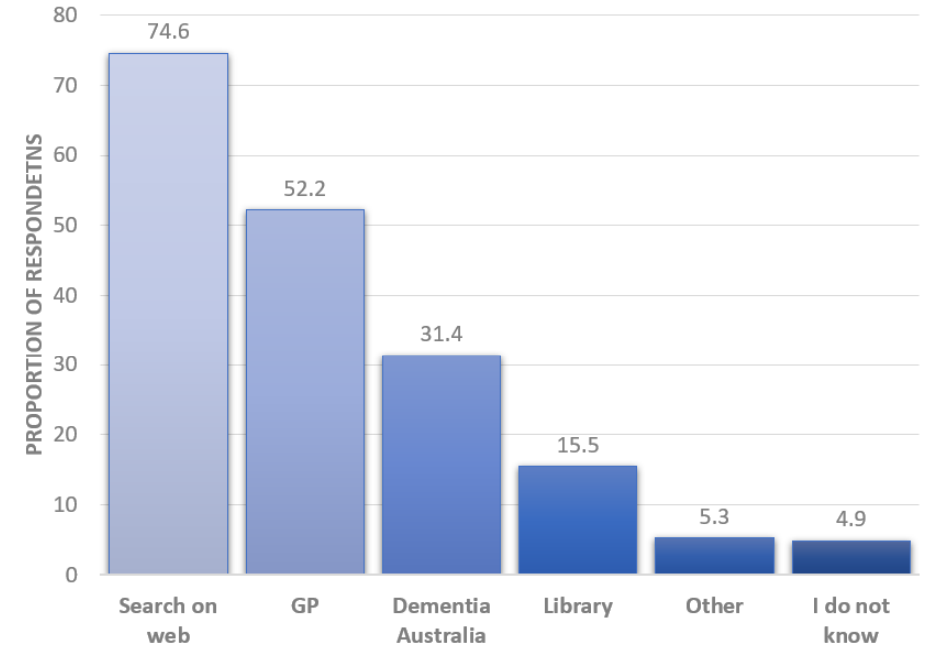
Figure 3. The proportion of respondents who reported on different information sources to support their dementia literacy.